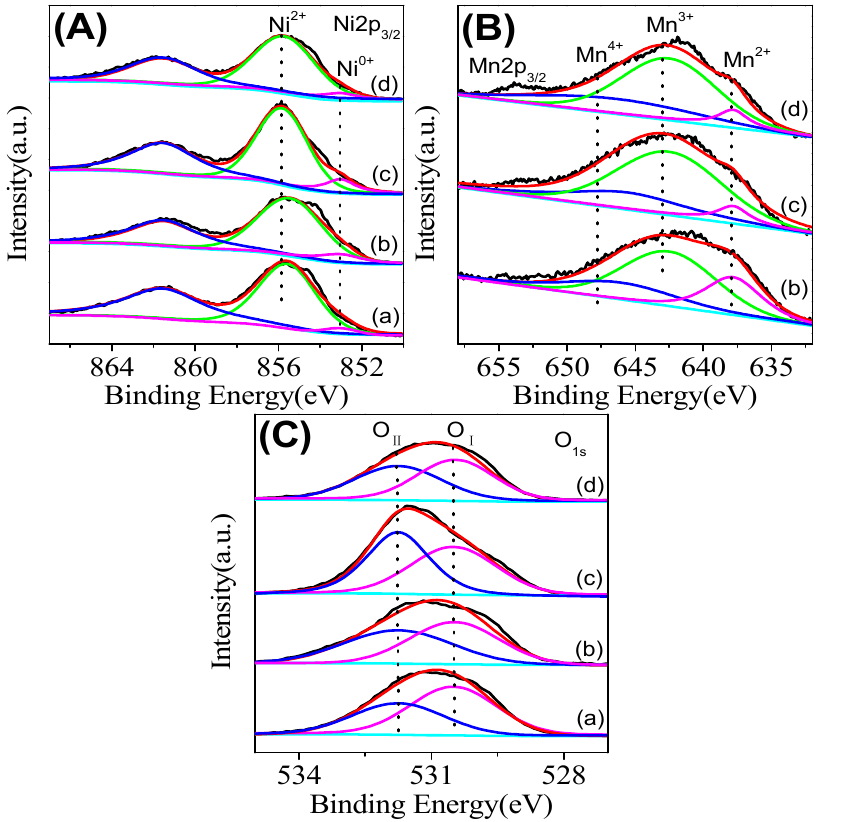
Figure 7. XPS spectras of the catalysts: ( A ) Ni 2p, ( B ) Mn 2p, ( C ) O 1s. (a) NiAl-C, (b) NiMn 0.5 Al 10 -C, ( C ) NiMn 1 Al 10 -C and (d) NiMn 2 Al 10 -C.